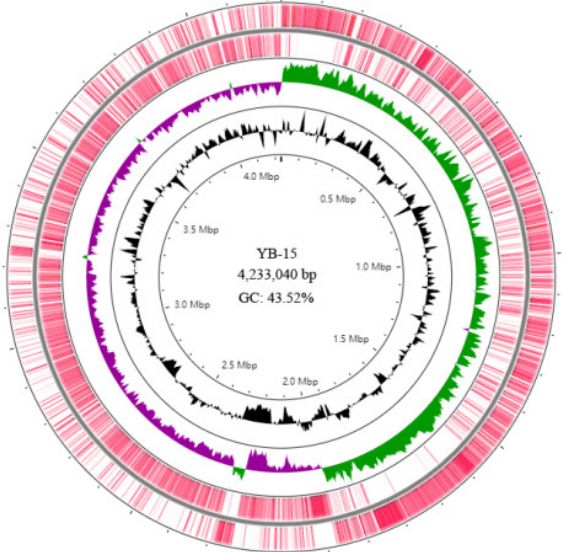
Figure 4. Circular map of B. subtilis YB-15 genome visualized by CGView Server. The distribution of rings from outwards to inwards be: ring 1 and 2 for protein-coding genes on the forward strand and reverse strand; ring 3 for GC skew in plus (green) and GC skew in minus (purple); ring 4 for GC content (black).